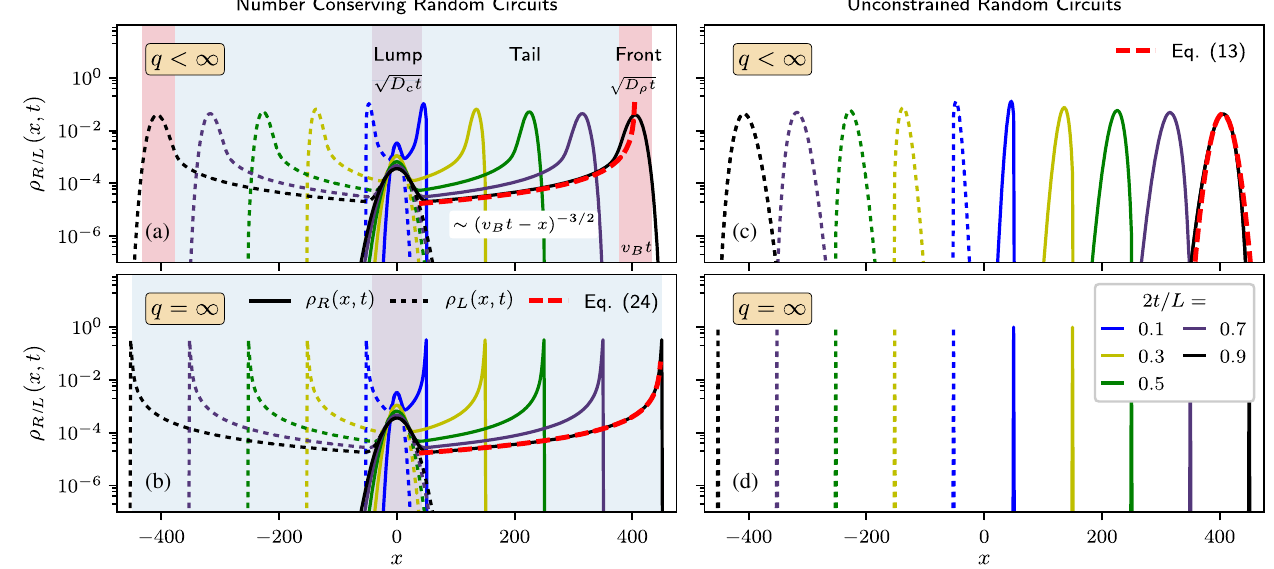
FIG. 3. (a),(b) Right/left-weight profiles ρ R=L ð x; t Þ showing the spreading of an initially local conserved charge ð z I Þ 0 ð t Þ in a random circuit model with S tot z conservation in a system of size L ¼ 1000 at different times t . These profiles depict three regimes. (i) A “ lump ” in ffiffiffiffiffiffiffiffi p D t the region j x j ≲ reflecting the weight of the operator on diffusively spreading conserved charges (shaded purple). This lump emits c ballistically spreading nonconserved operators at a slow power-law rate. This emission creates (ii) the leading ballistic “ fronts ” near j x j ∼ v B t within which the majority of the operator right and left weight is contained (shaded red for the latest time). These leading fronts are from nonconserved operators emitted at early times and they are perfectly sharp at q ¼ ∞ , where v B ¼ 1 (b), and have a width for finite q (a). Finally, the slow emission also leads to (iii) diffusive tails ∼ ð v B t − j x jÞ − 3 = 2 behind the leading fronts which reflect the operator weight in “ lagging ” fronts of nonconserved operator strings that were emitted at later times (shaded blue for the latest time). The curves in (a) are obtained via a simulation at q ¼ 3 , which takes into account the different processes (diffusion of charges, emission of nonconserved operators, and the biased diffusion of the nonconserved right and left weights) to order 1 =q 2 . The red dashed curve is the exact infinite q answer for the “ tail ” Eq. (24). (c),(d) For comparison, ρ R=L ð x; t Þ in an unconstrained random circuit model [37,38], where z 0 ð t Þ is not “ special. ” Regimes (i) and (iii) do not exist in an unconstrained circuit, and the ballistically spreading operator fronts describe the entire right- and left-weight profiles. The fronts are again infinitely sharp at q ¼ ∞ (d) and have a finite width ∼ q < ∞